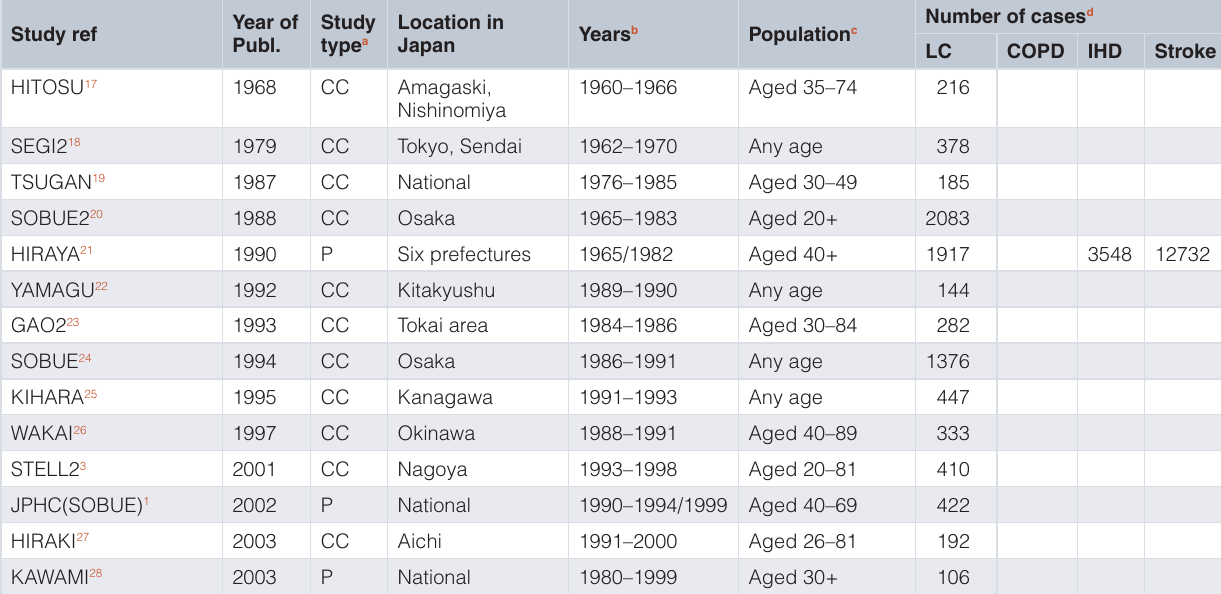
Table 1. Details of studies